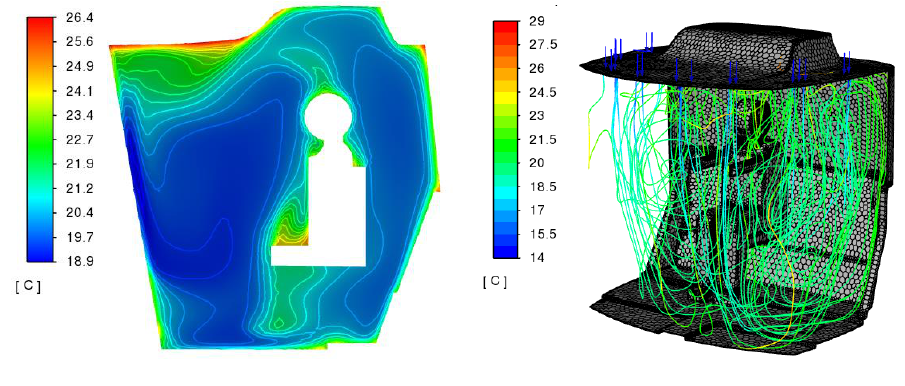
Figure 10. Temperature, °C.